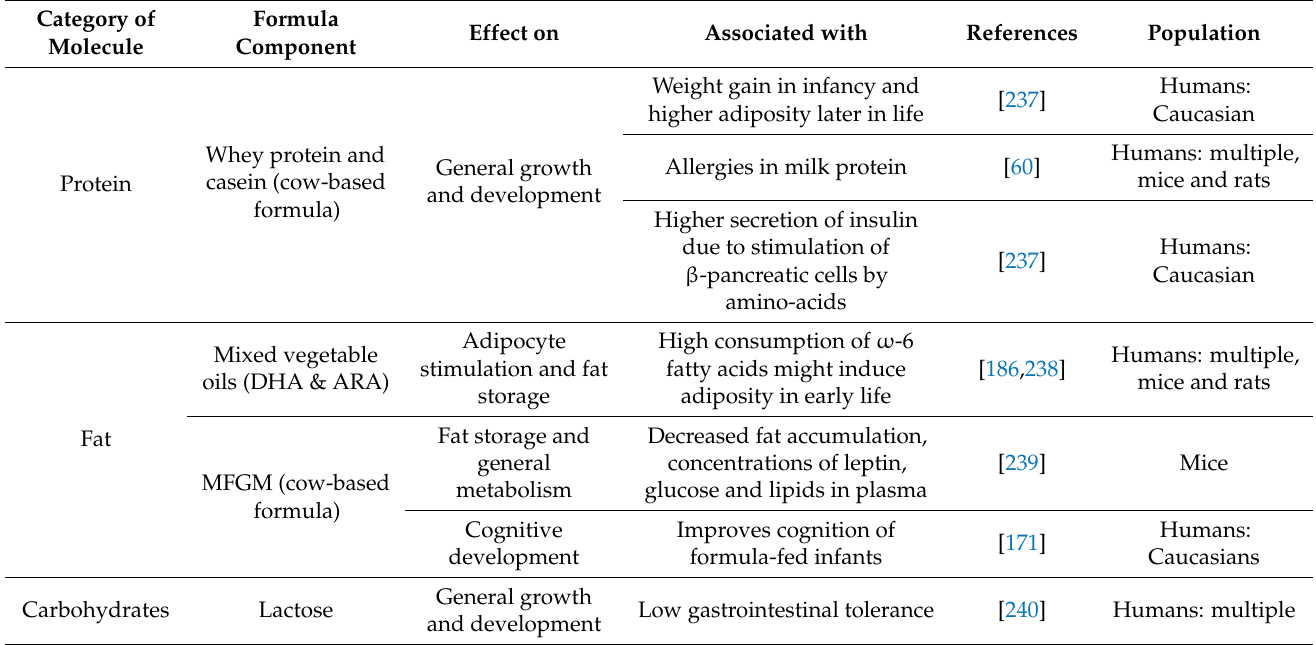
Table 4. Macronutrients in infant formula and their effect in infant